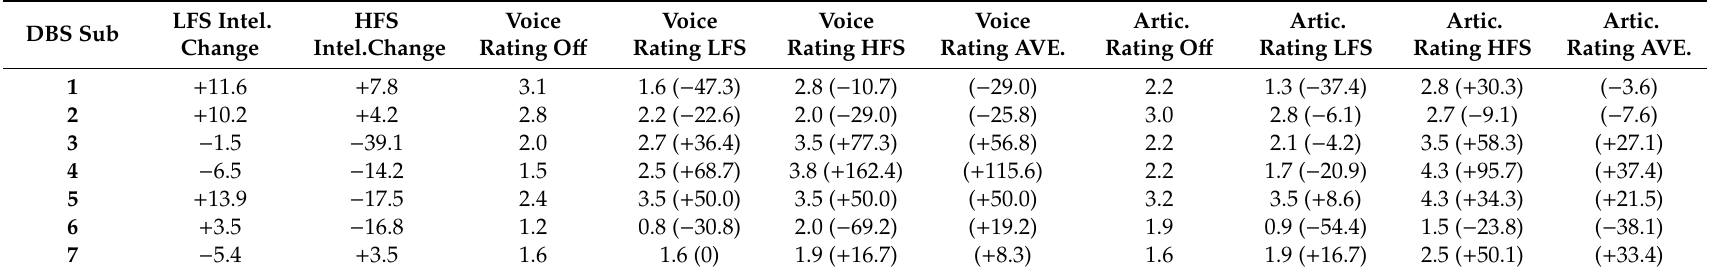
Table 2. The percent change in intelligibility (Intel.) calculated using each subject’s intelligibility using DBS o ff as the reference value. Positive values represent improved intelligibility, negative values represent reduced intelligibility. Unlike the previous analyses that treated listeners as subjects, this summary averages the intelligibility scores across all listeners for each DBS subject. Two of the DBS subjects (# 1, 2) had increased intelligibility under both LFS and HFS conditions. Two of the DBS subjects (# 3, 4) had decreased intelligibility under both LFS and HFS conditions. The remaining three DBS subjects had mixed results. The table also represents each subject’s voice and articulation (Artic.) ratings by listeners under the DBS O ff , LFS, and HFS conditions. The percentage of change with reference to the DBS O ff condition is presented in parentheses. The “Rating Ave.” columns represent the average percent changes for the LFS and HFS